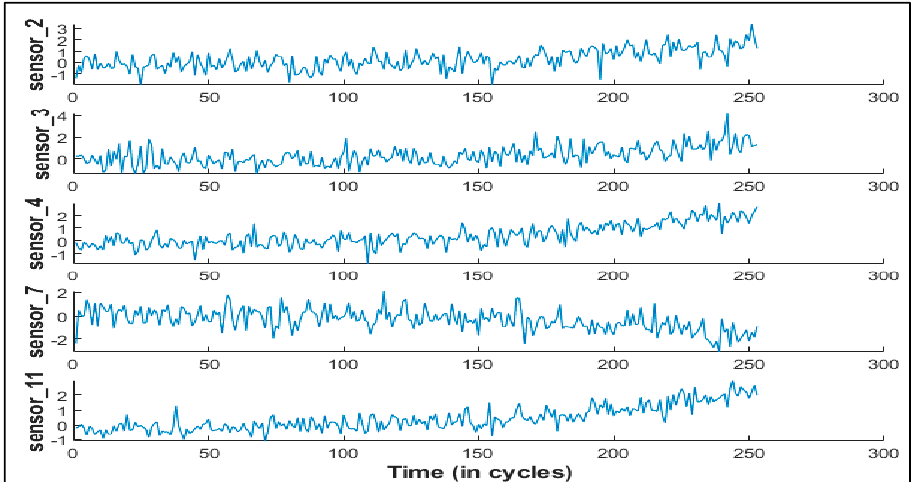
Figure 5. Degradation pattern of five useful sensors.